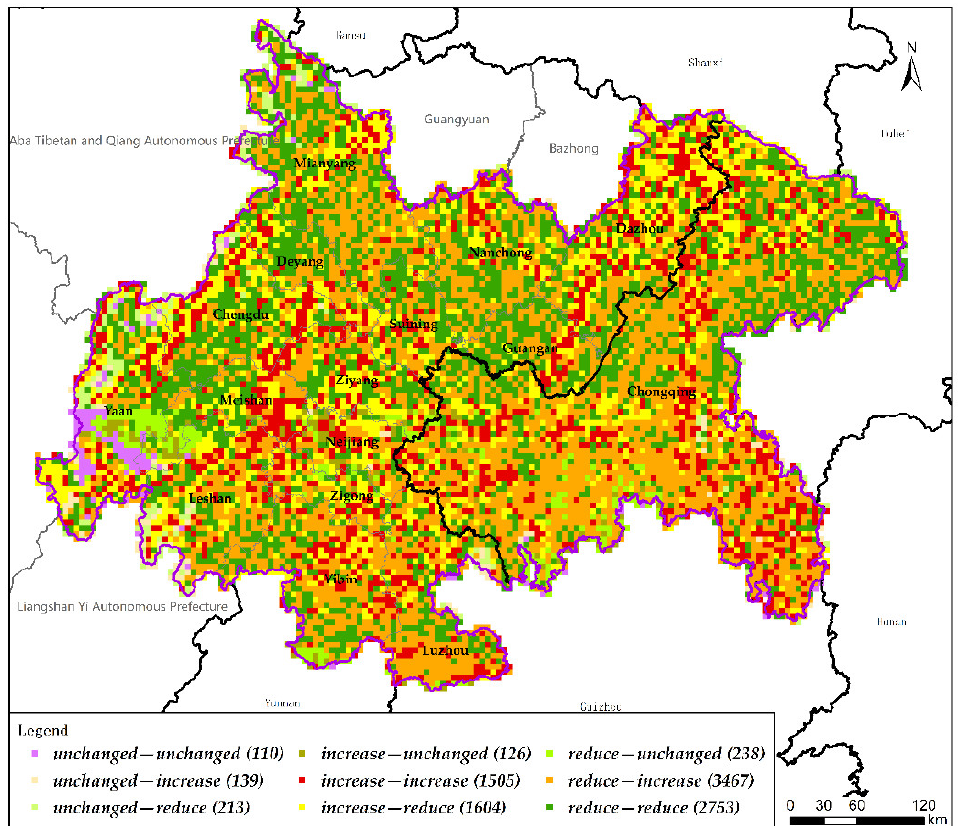
Figure 6. Changes in the risk values of each risk community from 2000 to 2010 and from 2010 to 2020.